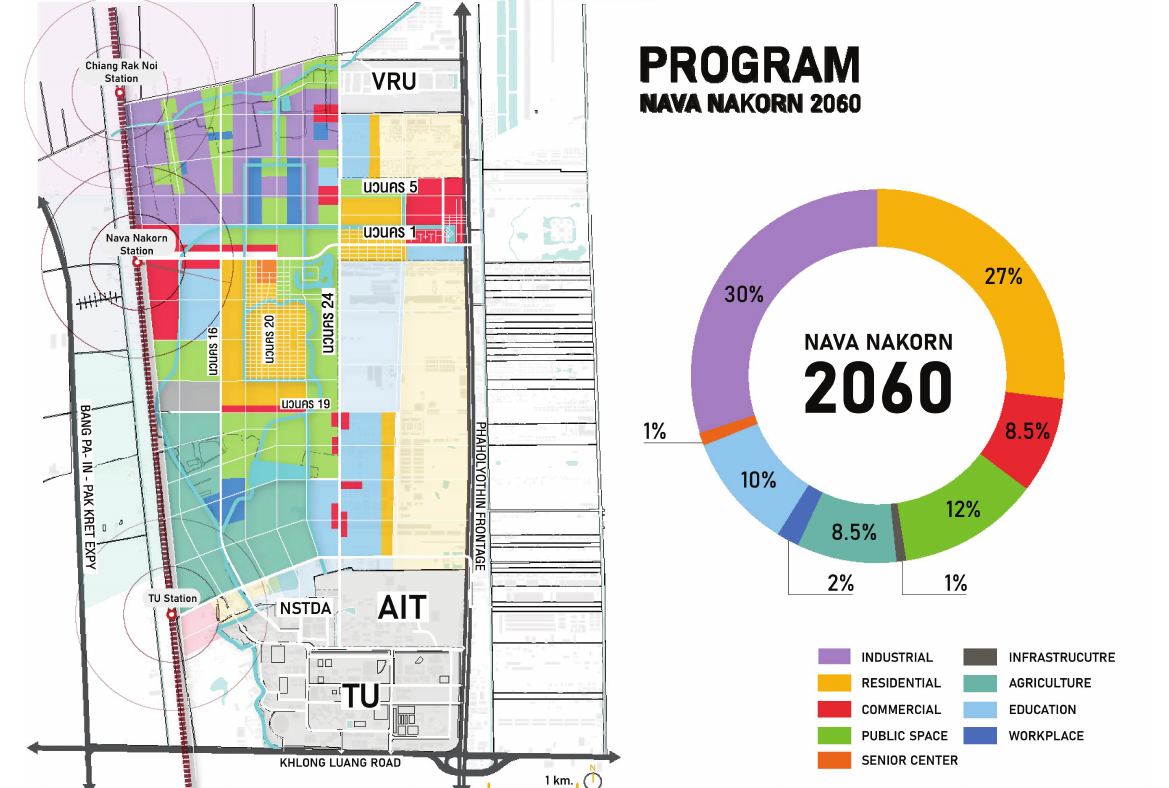
Figure 4. Envisioned land use in the VRU/Nava Nakorn/Thammasat University corridor of the superblock, 2060. Graphics credits to Thanakit Singduang, Thanyamon Traimittaparp,